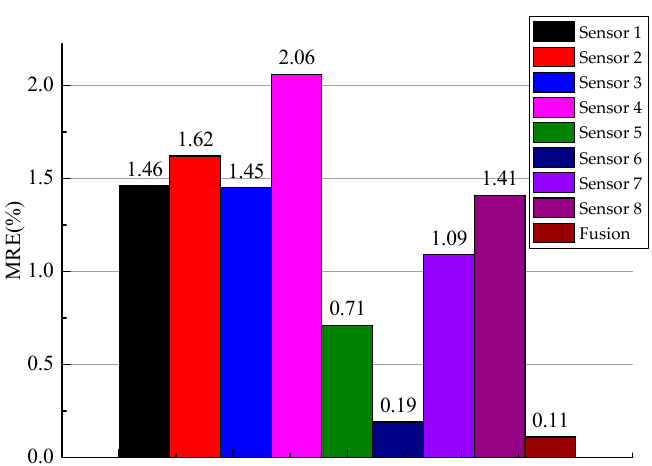
Figure 20. MRE of experimental result.